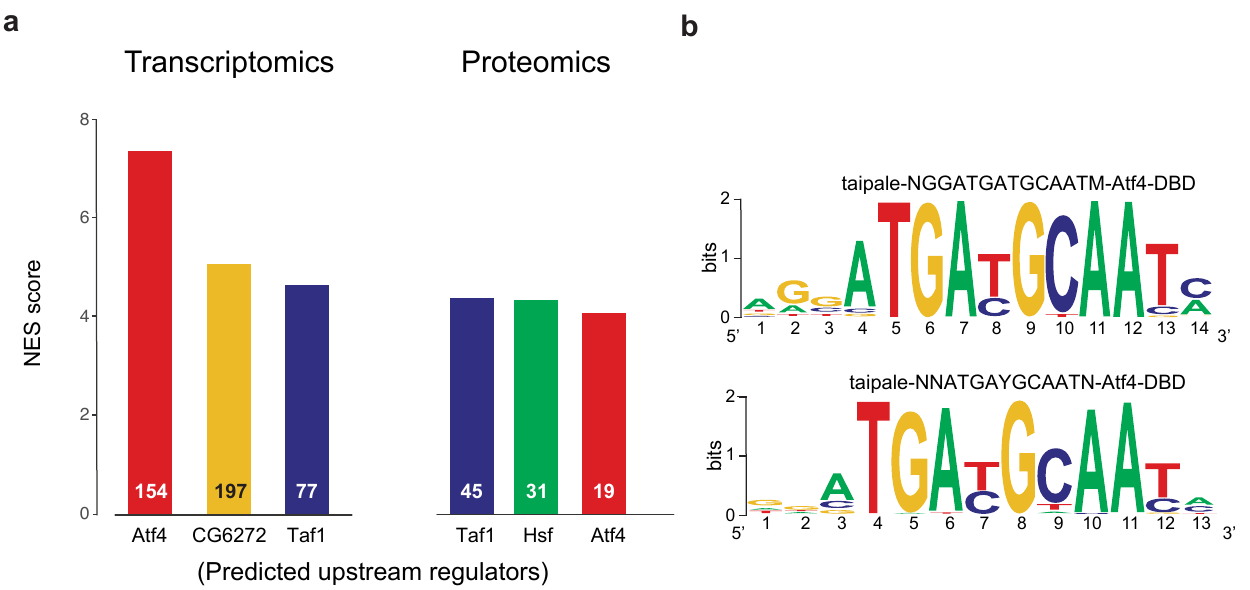
Figure 2. Upstream analysis of dPerk-upregulated transcripts and proteins. ( a ) Predicted upstream regulators of upregulated transcripts (left) and proteins (right) and their respective NES scores. The number of targets regulated by the specific transcription factor (TF) is presented on the bars. ( b ) Highest-ranking motifs of the ATF4 TF observed in upregulated transcripts. The analysis was performed using iRegulon, a Cytoscape